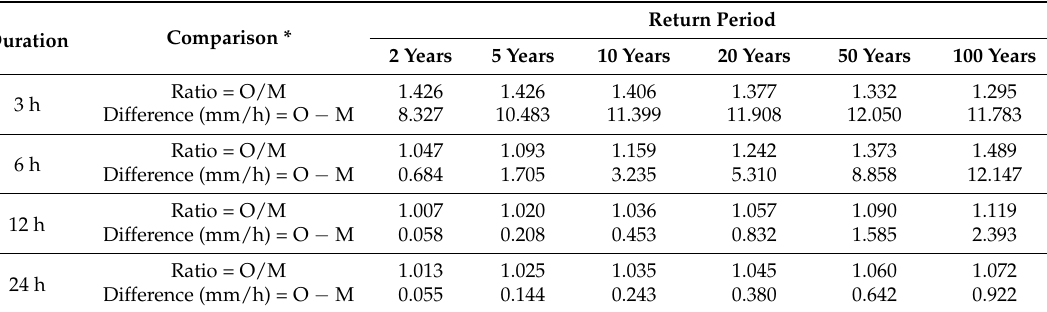
Table 4. Ratio and difference between observed and simulated rainfall intensities.